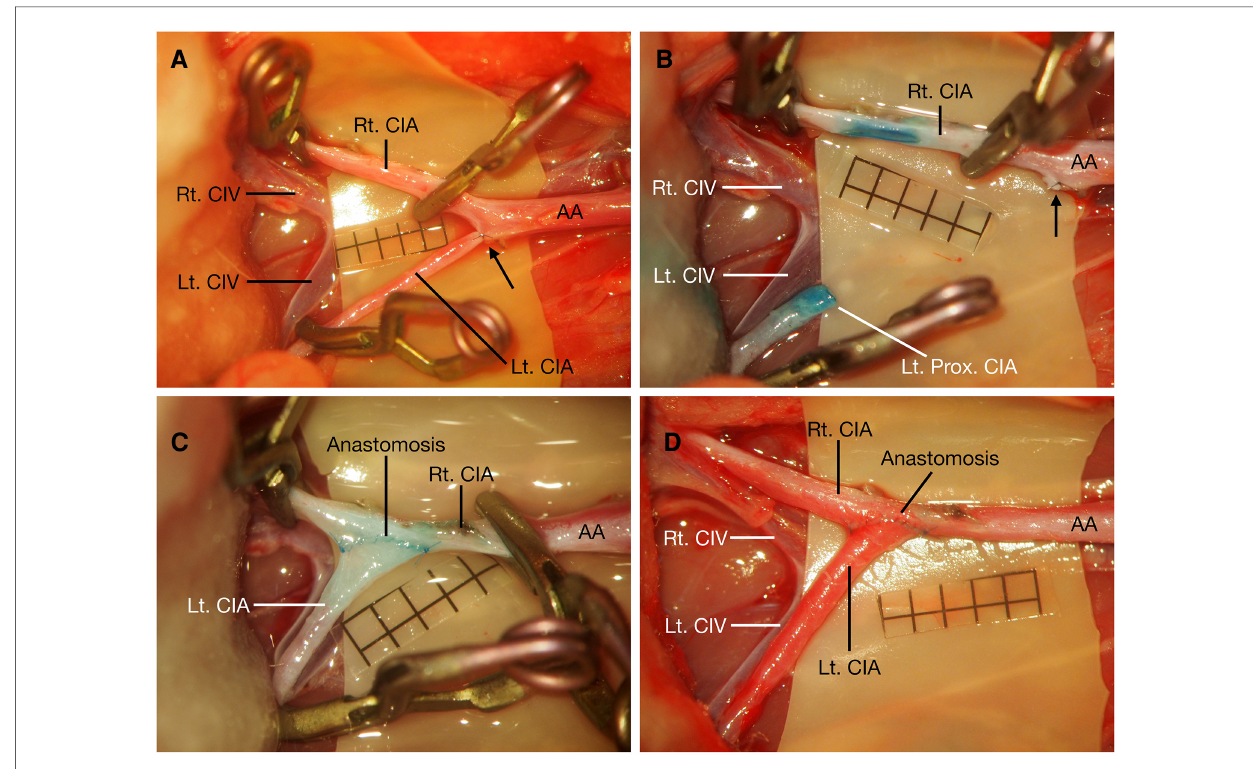
FIGURE 3 Proximal CIA to contralateral CIA end-to-side anastomosis. After bilateral CIAs were carefully dissected, the right CIA was temporarily occluded, the distal part of the left CIA was temporarily occluded, and the proximal part was ligated at its origin (black arrow) ( A ). The proximal left CIA was divided distal to the ligation point (black arrow), and the cutting end of the CIA was cut in a fi sh-mouth fashion; an arteriotomy was made on the right CIA ( B ). Proximal CIA to contralateral CIA end-to-side anastomosis was performed ( C ), and blood fl ow was restored by releasing these temporary clips ( D ). Scale bar=1 mm. AA, abdominal aorta; CIA, common iliac artery; CIV, common iliac vein; Lt., left; Prox., proximal; Rt.,